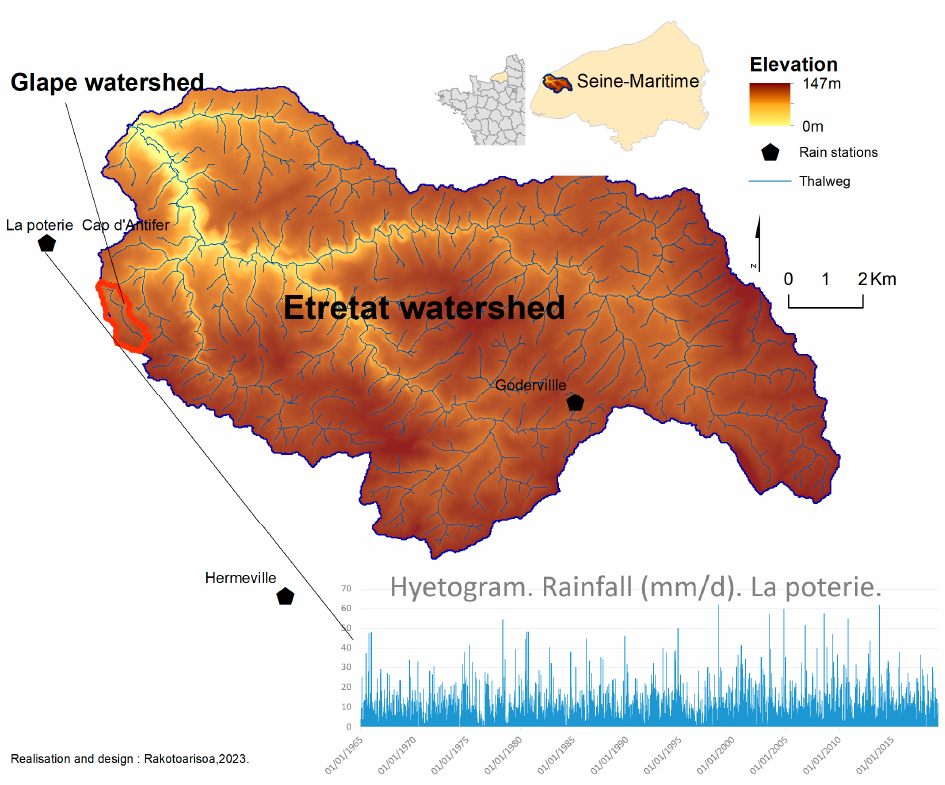
Figure 2. Location of the study basin (Glape basin) and rain stations.